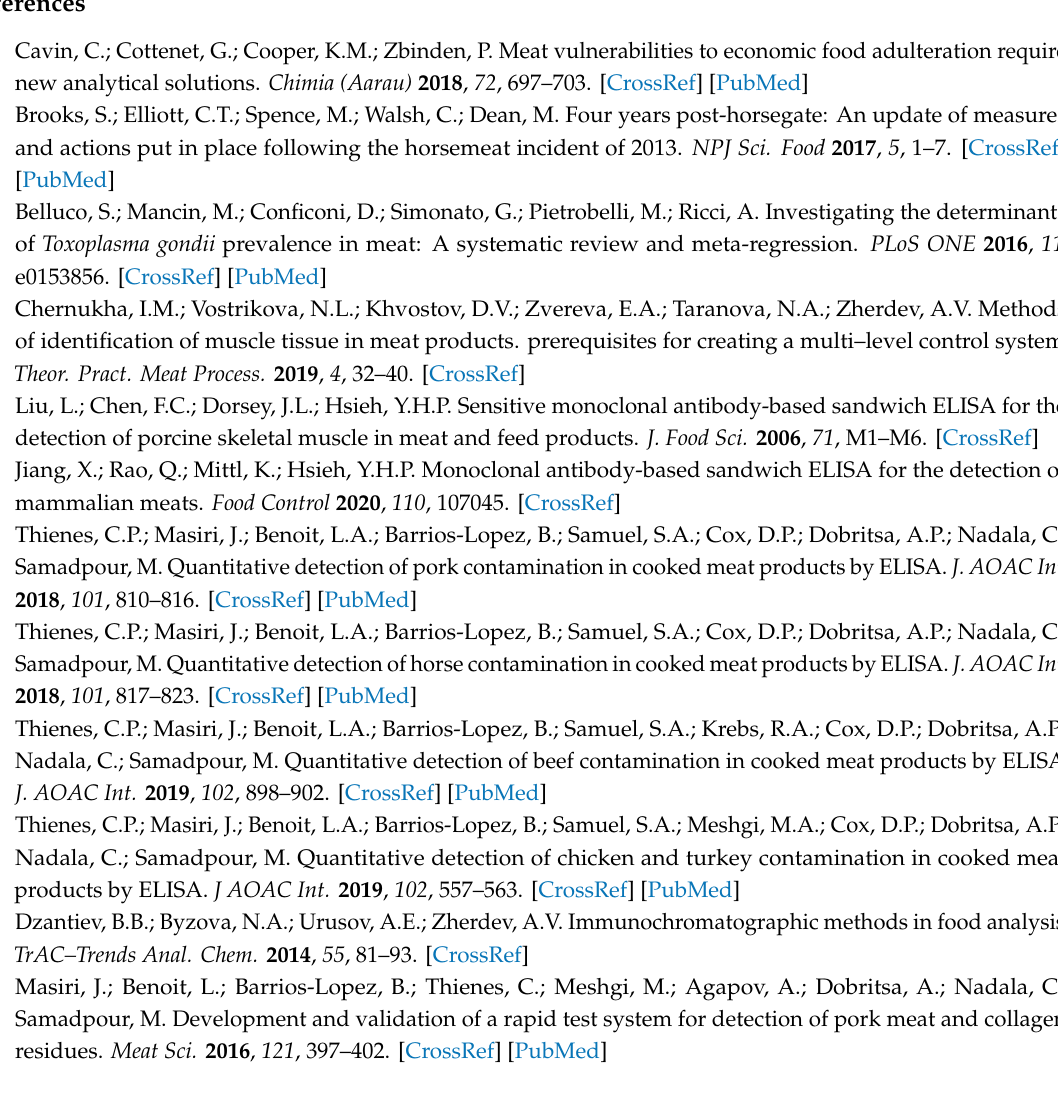
Figure S1. Calibration curve of the bovine TnI detection by sandwich ELISA. Table S1. Composition of